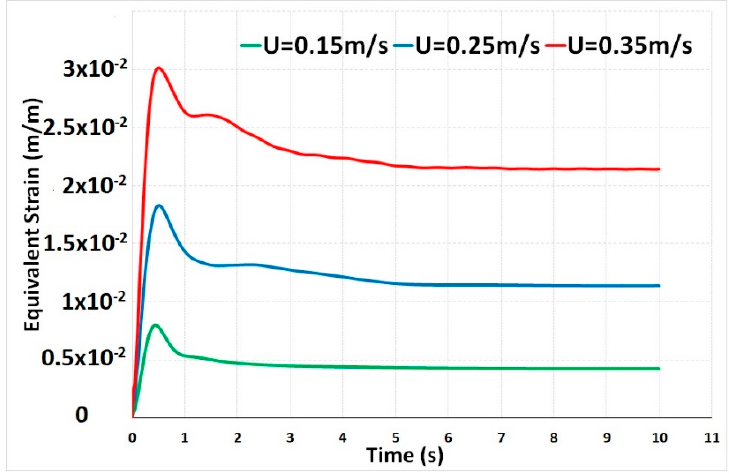
Figure 12. Variation of equivalent strain of T-shaped flexible beam between t = 0 s and 10 s.